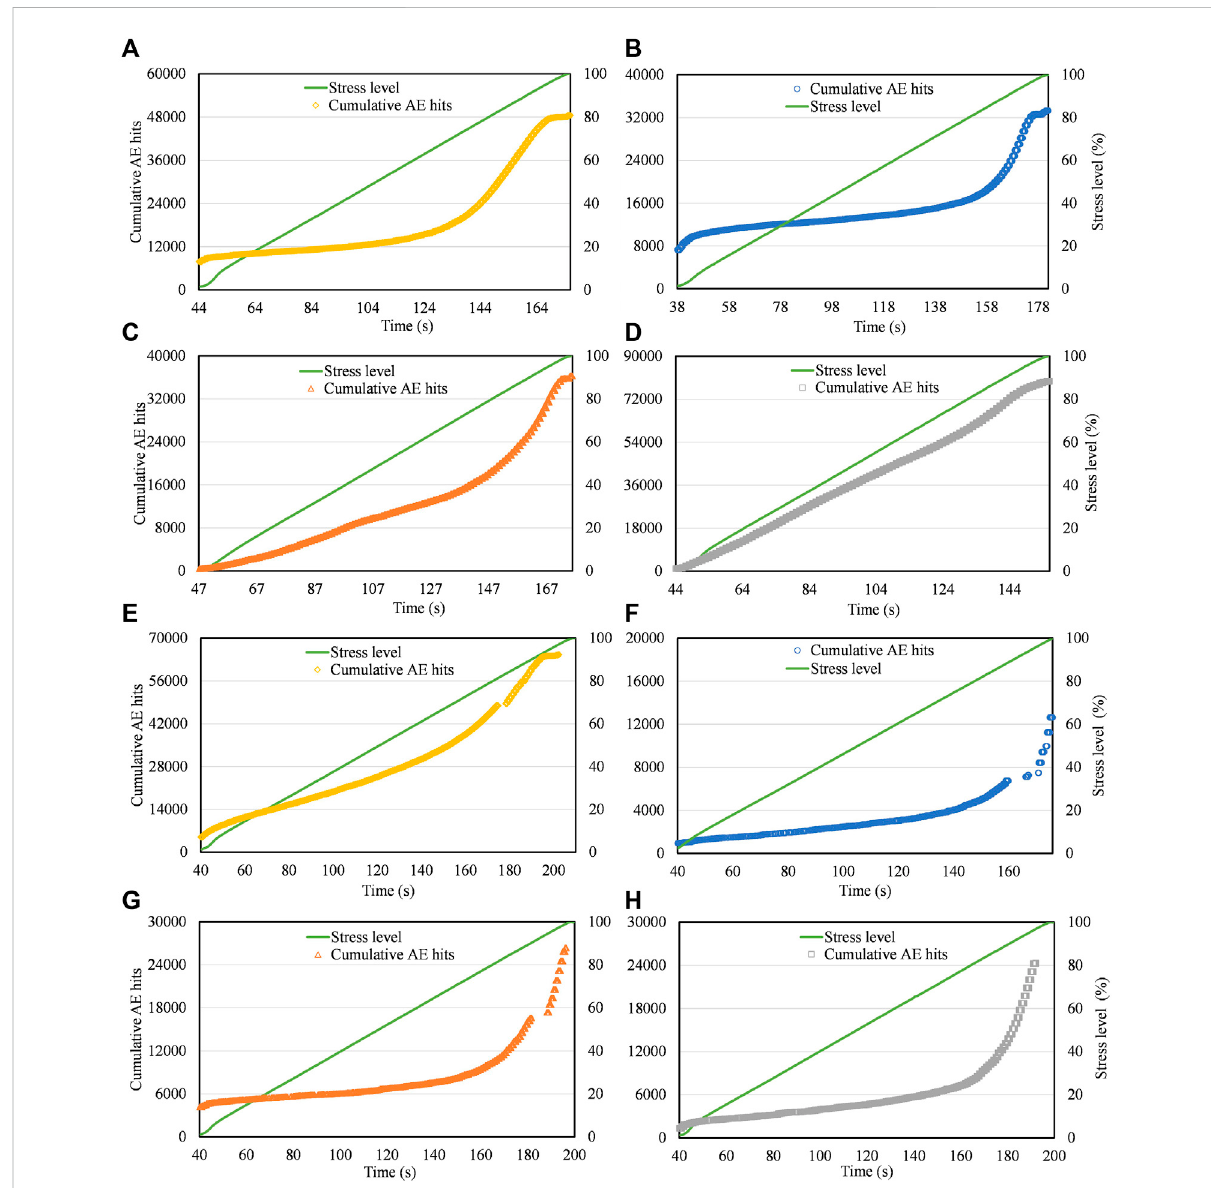
FIGURE 12 CumulativeAEhitsduring compression test (A) Healthy condition inuncoated case. (B) Initiation stagein uncoated case. (C) Acceleration stage in uncoated case. (D) Deterioration stage in uncoated case. (E) Healthy condition in coated case. (F) Initiation stage in coated case. (G) Acceleration stage in coated case. (H) Deterioration stage in coated